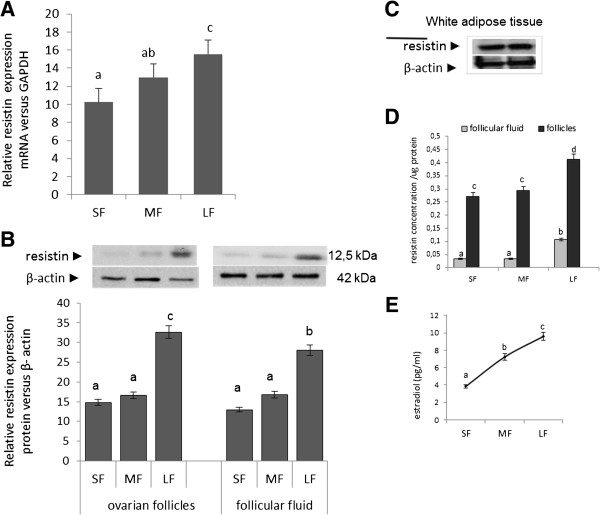
Resistin expression and concentration in ovarian follicles. Resistin expression and concentration in ovarian follicles collected from prepubertal animals; A) The ratio of resistin gene intensity to GAPDH intensity was used to represent the abundance of resistin mRNA in the ovarian follicles. B) The amount of protein (50 μg) in every sample was checked by immunoblot using anti-β-actin antibody. Upper panels: representative blots of tissue homogenates resolved by 15% SDS–PAGE, immunoblotted with resistin antibodies and reprobed with β-actin antiserum. Lower panels: results of densitometric quantification of bands. The data are expressed as the mean±SEM of rations relative to GAPDH or to β-actin. C) For positive control we used porcine white adipose tissue. D) Concentrations of resistin in follicular fluid and ovarian tissue. Different letters indicate statistically significant differences among groups (P < 0.05). E) Estradiol concentrations in follicular fluid.